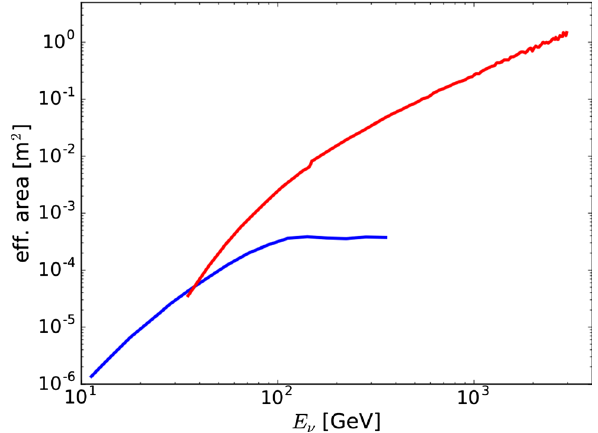
Fig. 2 Median angular resolution as a function of B 1 mass for the IceCube 86-string configuration (IC-86, blue line) and the 22-string configuration (IC-22, orange line). The bump at m B 1 = 100 GeV in the former is due to the transition from DeepCore resolution to IceCube resolution [18]. Values calculated at the discrete mases denoted by the dots. Lines are a linear interpolation between the dots to guide the eye